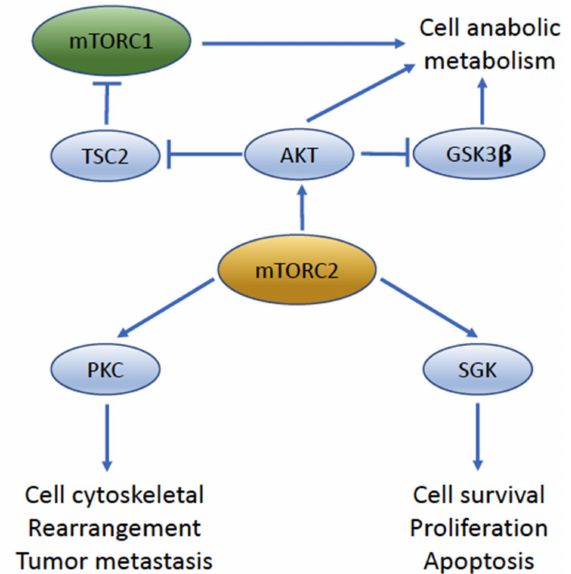
Figure 4. The key downstream target molecules and function pathways of mTORC2. mTORC2 activates the AGC (protein kinase A/protein kinase G/protein kinase C) family kinases PKC, AKT, and SGK to regulate the cytoskeleton, metabolism, and ion transport and promote cell survival. PKC, protein kinase C; SGK, serum- and glucocorticoid-induced protein kinase; GSK3 β , glycogen synthase kinase 3 β ; TSC2, tuberous sclerosis complex